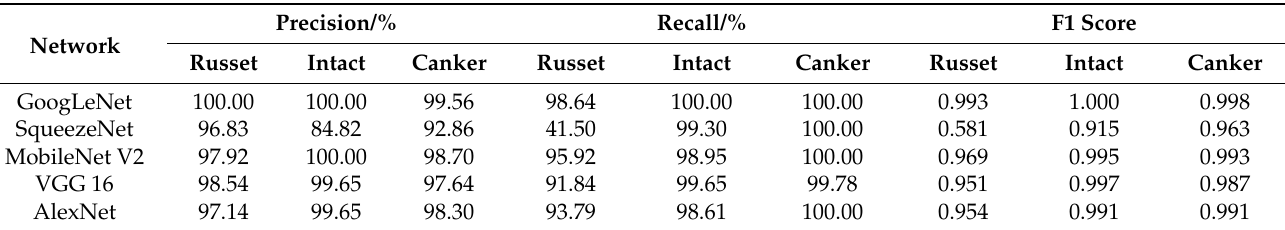
Table 4. Results of testing set using different CNN